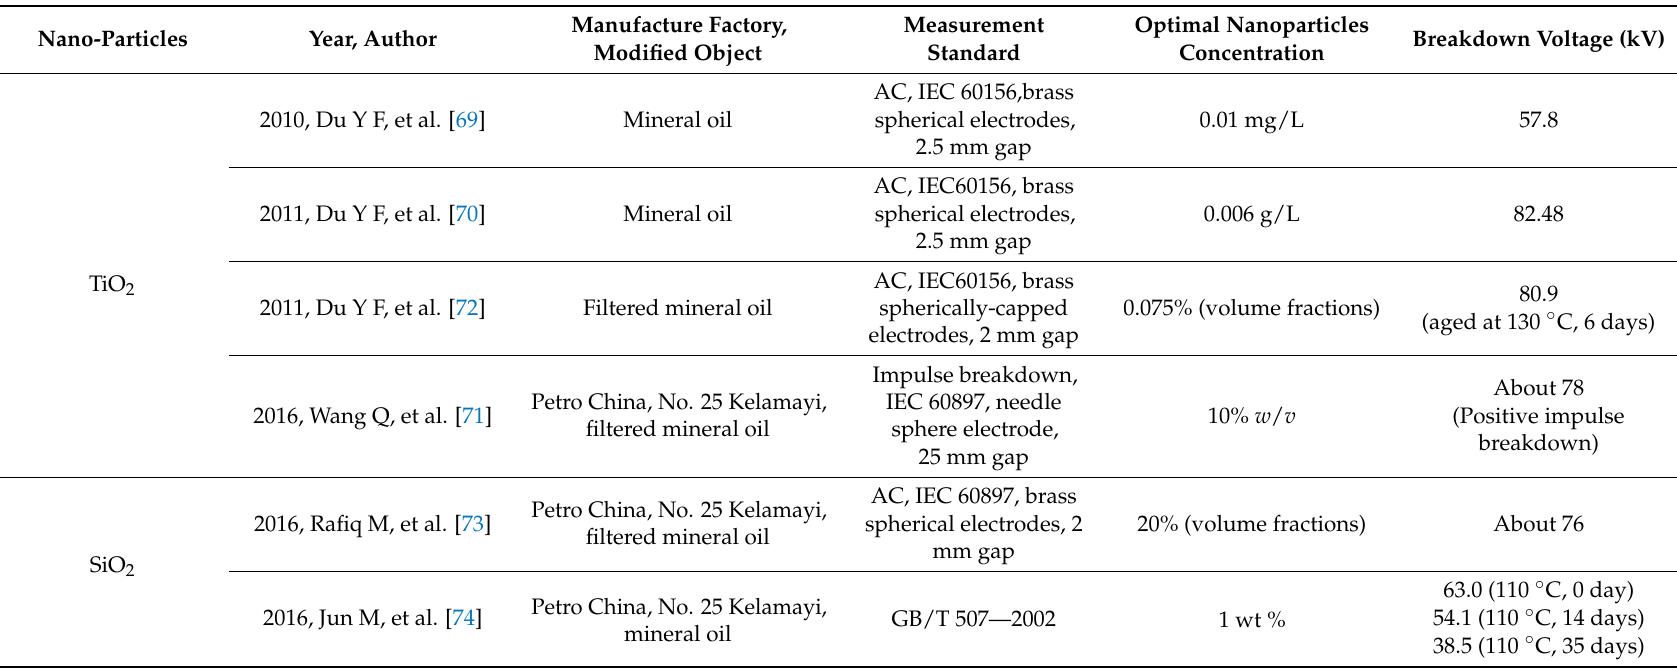
Table 2. Breakdown voltages of mineral insulating oil modified with nano-TiO 2 and nano-SiO 2